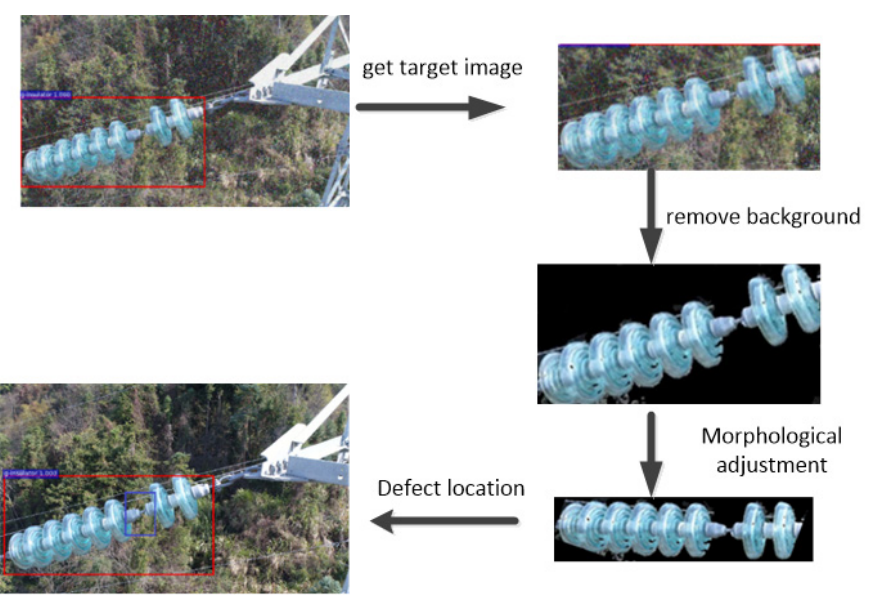
Figure 12. The process of insulator defect detection.